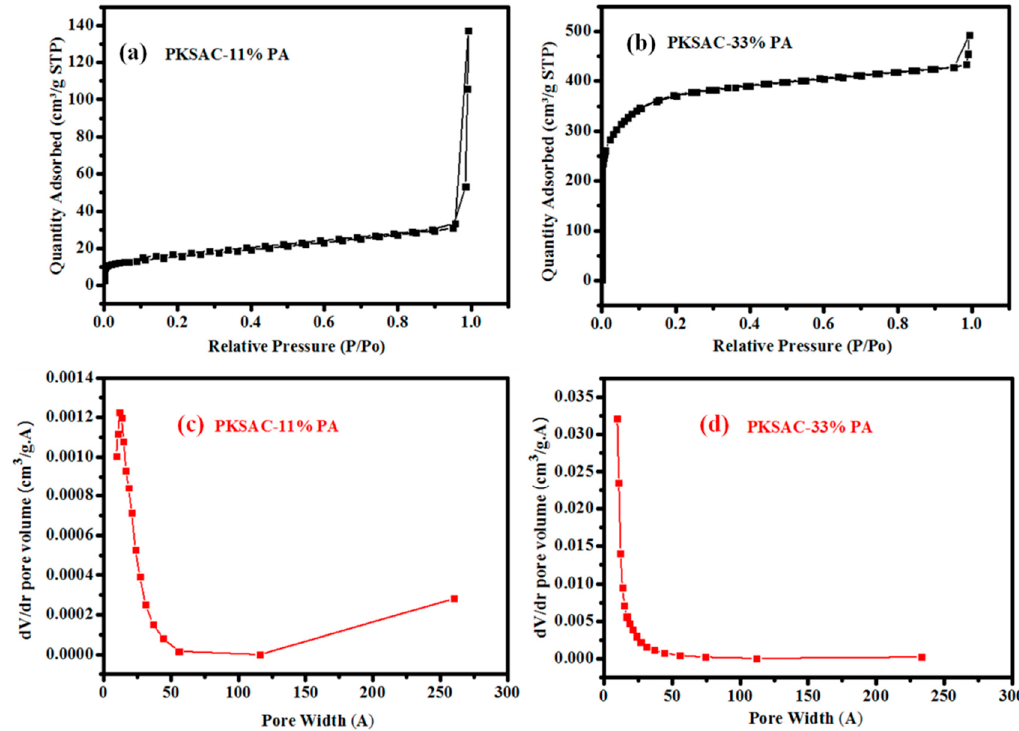
Figure 3. ( a , b ) The nitrogen adsorption–desorption isotherms, at 77 K, of PKSAC-11% PA and PKSAC-33% PA, respectively; and ( c , d ) represents their corresponding pore size distributions. “PKSAC: Palm Kernel Shell-derived Activated Carbon; PA: Phosphoric Acid”.